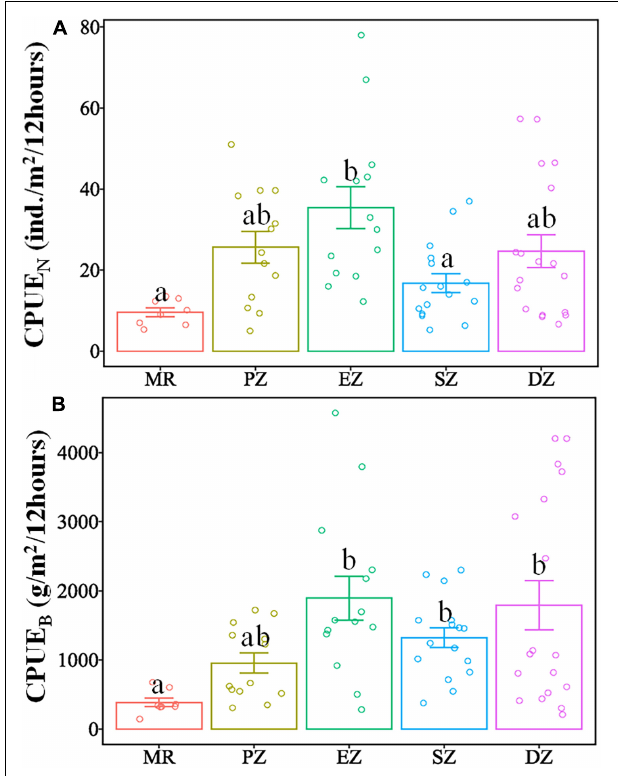
FIGURE 4 | Mean catch per unit effort (CPUE N and CPUE B ) of all fish species combined sampled from the Mangshe River (MR) and different purification zones of Lake Yanlong (PZ, the pretreatment zone; EZ, the emergent macrophyte zone; SZ, the submerged macrophyte zone; DZ, the deep purification zone) (A,B) . Letters above bars denote significant differences among zones. Error bars represent 1 SE.